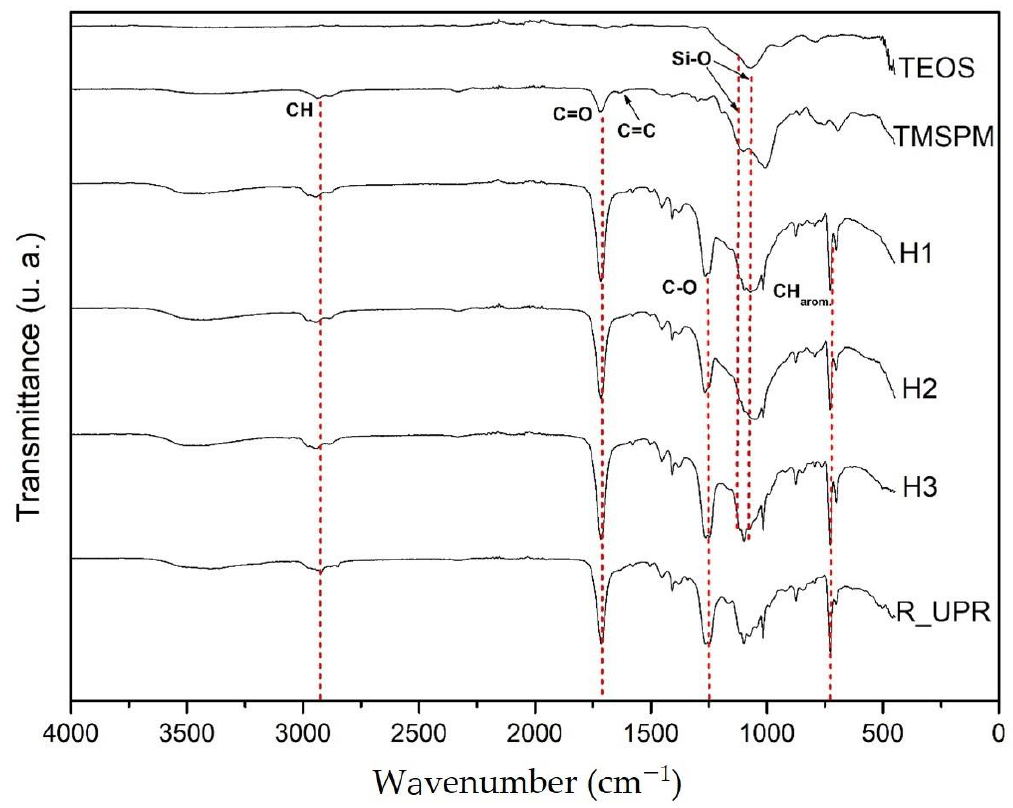
Figure 2. The FT-IR spectra of TEOS, TMSPM, H1, H2, H3, and R-UPR.